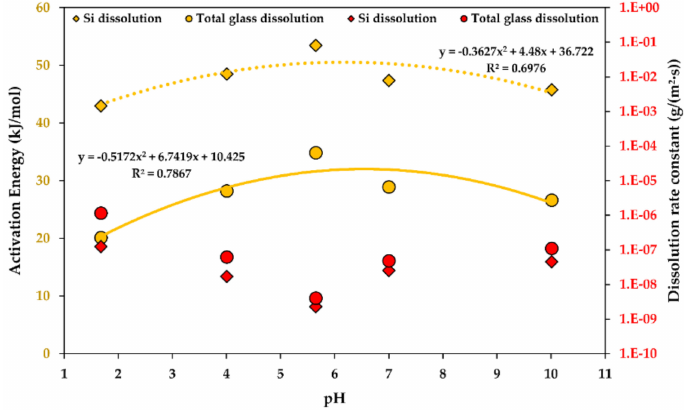
Figure 5. The activation energy (yellow) and the rate constants (red) of the steady-state R-glass dissolution as a function of the pH . Determination coefficients R 2 are shown. 1.E-10 stands for “1 × 10 − 10